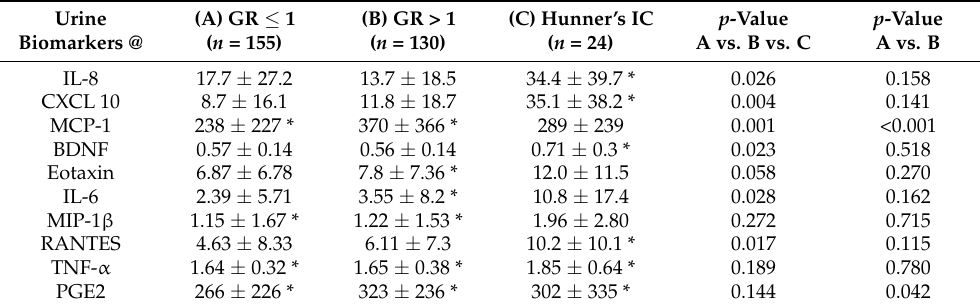
Table 3. The urine biomarkers among IC/BPS subgroup patients with different grade of glomerula- tions or Hunner’s lesion.